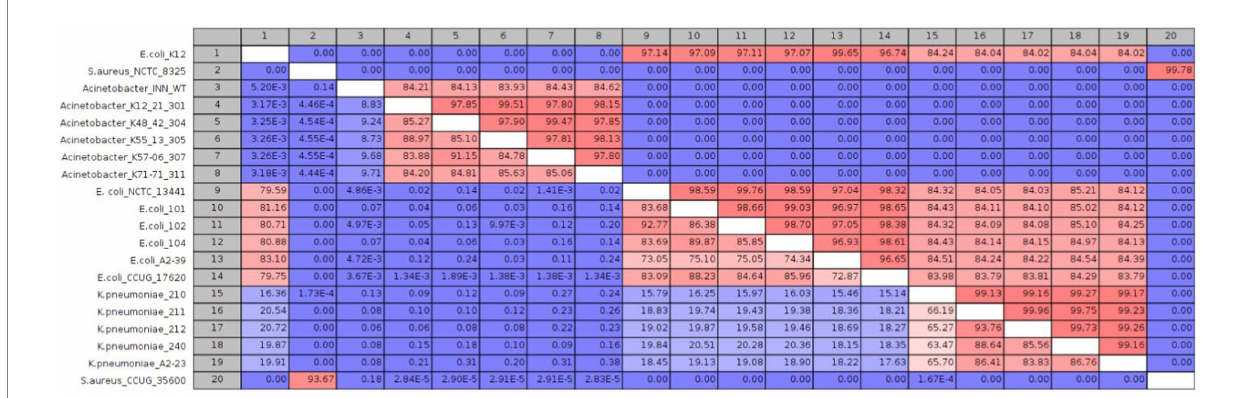
FIGURE 4 Whole-genome alignment for the 20 sequenced isolates. The upper and lower comparison gradient shows the percentage of nucleotide similarity and alignment percentage between genomes,